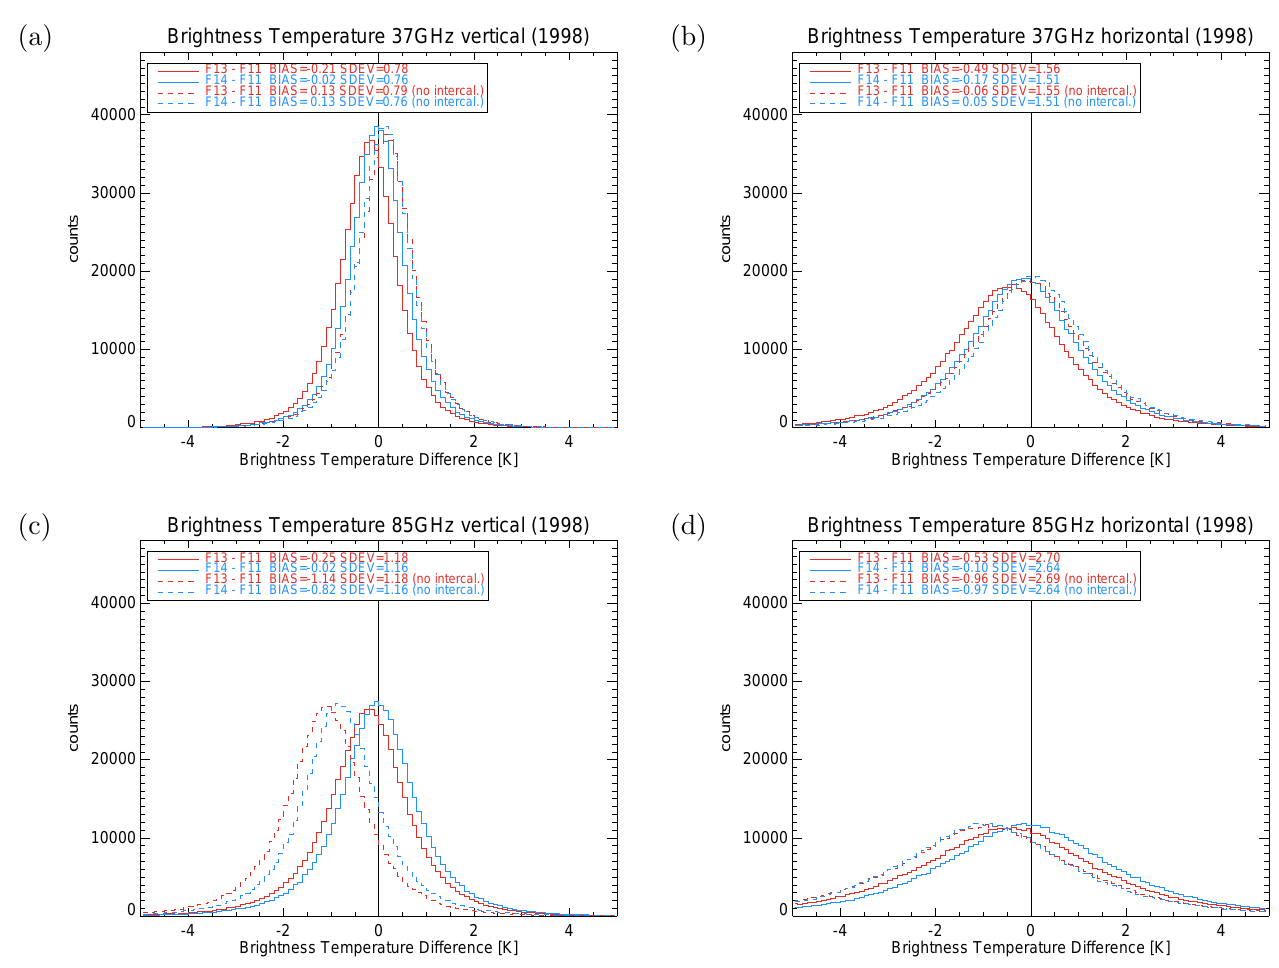
Figure 6. Same as Fig. 5, but for TB 37v (a) , TB 37h (b) , TB 85v (c) , and TB 85h (d) .